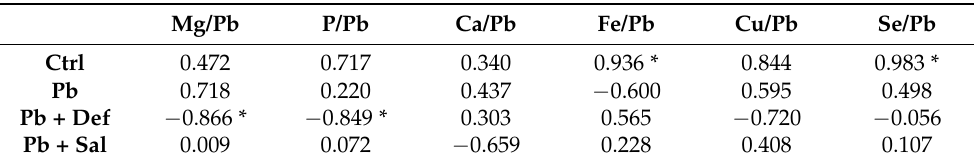
Table 4. Pearson’s correlation coefficients for the interaction of Pb with the essential elements in the kidneys of the experimental